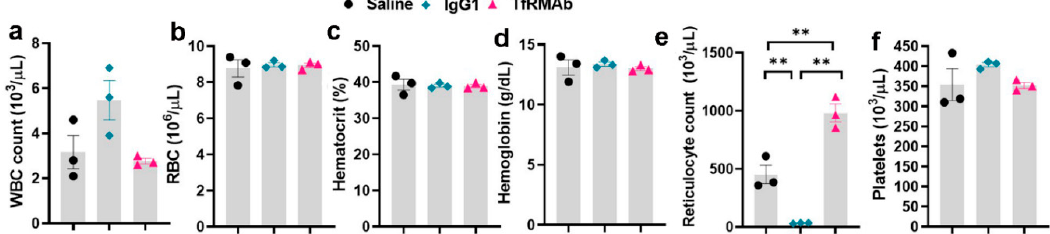
Figure 4. Complete blood count (CBC) data following chronic dosing of the high-a ffi nity bivalent TfRMAb in mice. Mice were treated 3 days per week for four-weeks with a 3 mg / kg SQ dose of TfRMAb, IgG1, or an equivalent volume of saline, and a CBC ( a – f ) was performed at the end of two weeks. Data are shown as the mean ± SEM of n = 3 per group. ** p <